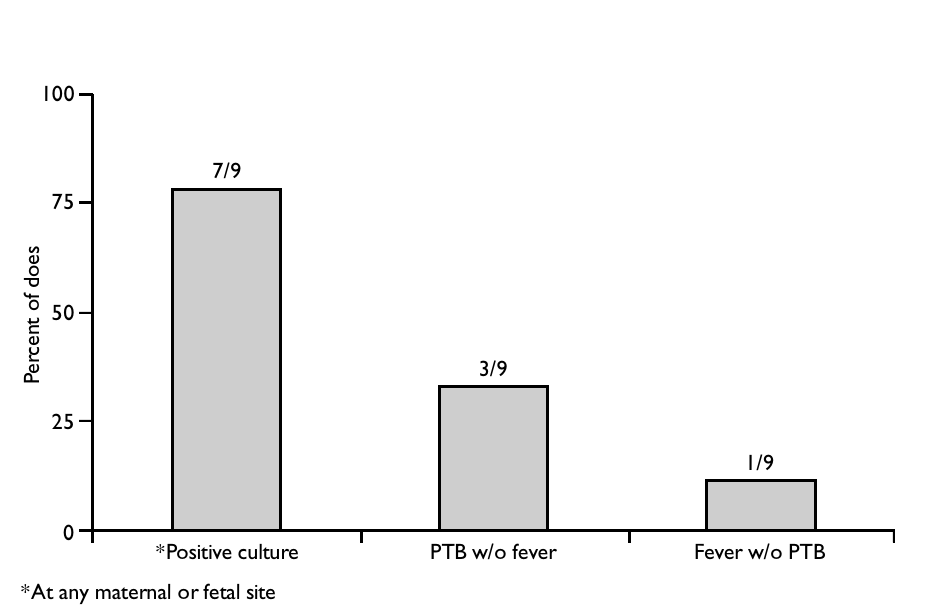
Figure 1 Outcomes in nine does inoculated with 10 5–6 P. bivia and observed for 6–7